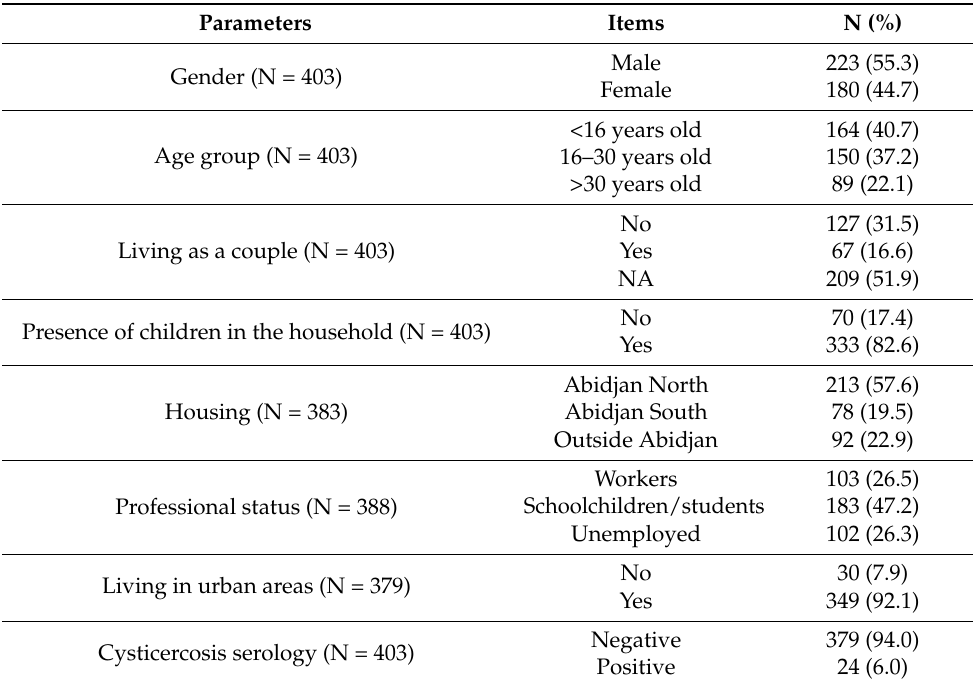
Table 1. Characteristics of epileptic patients diagnosed in public neurology services of the city of Abidjan between September 2015 and February